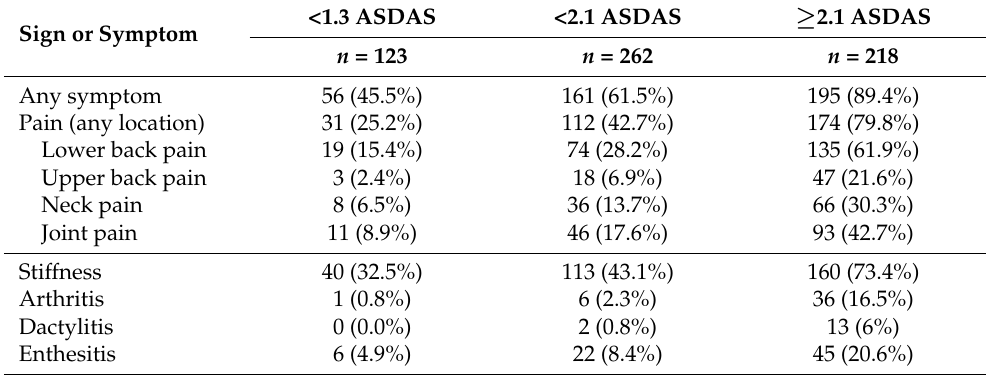
Table 4. Residual signs and symptoms in patients with axial spondyloarthritis stratified by ASDAS.